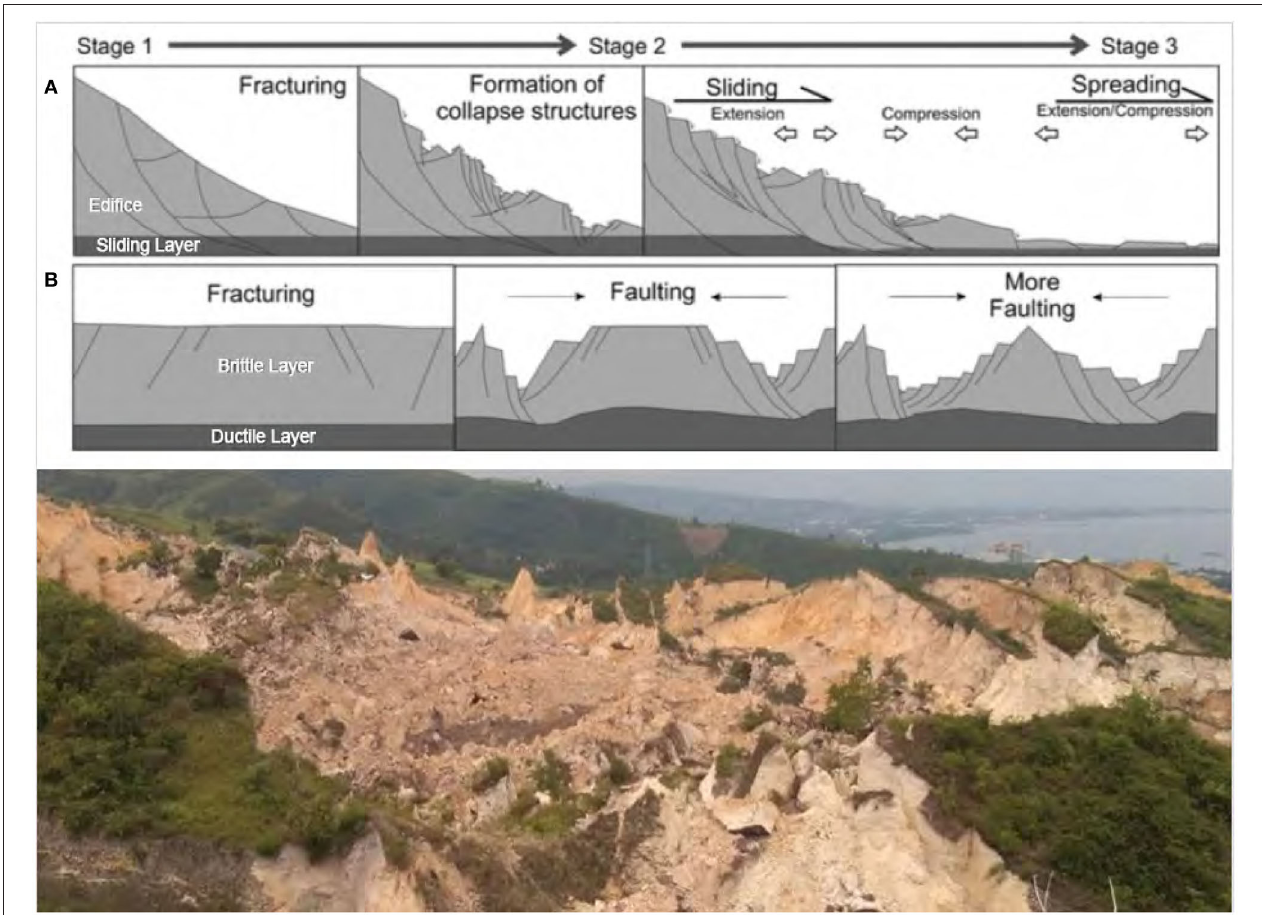
FIGURE 14 | Comparison of analog models of Paguican et al. (2014) with the Naga landslide hummocks and toreva blocks. (A) The different stages of avalanche emplacement showing an interpretation of hummock formation and (B) degree faulting.